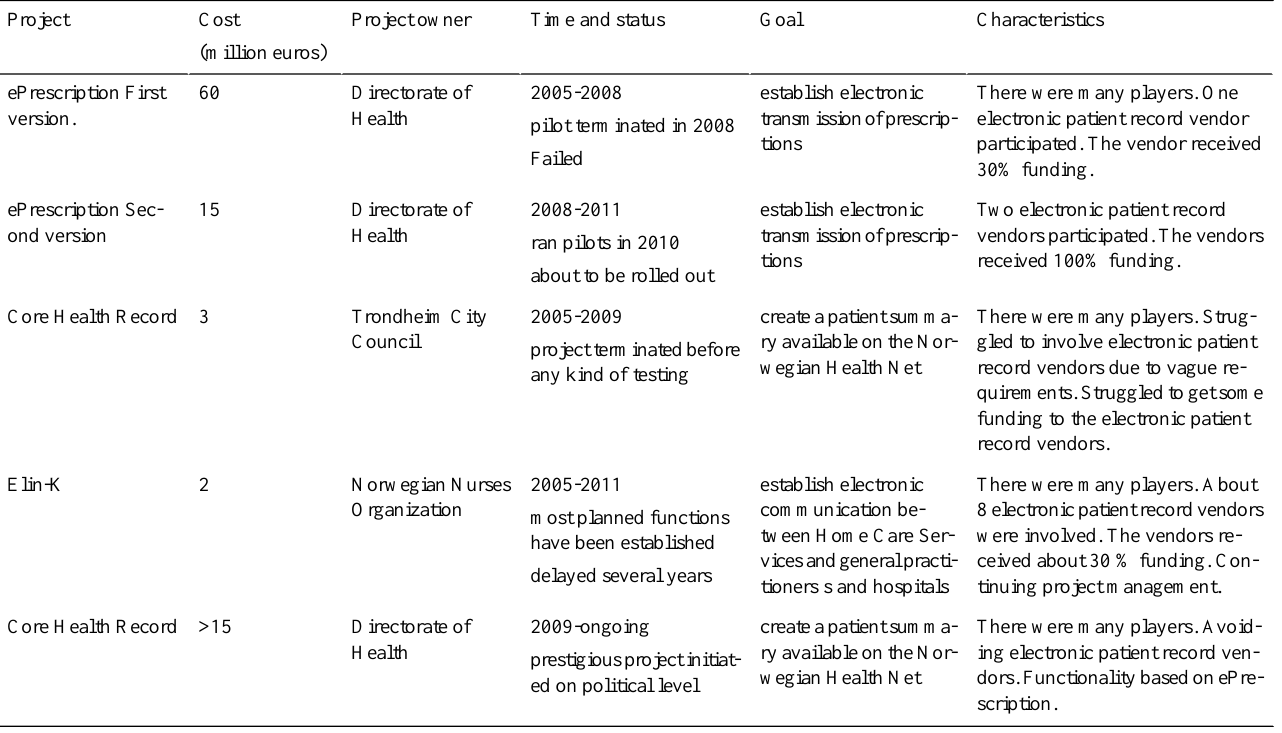
Table 1. Public projects underway in Norway since